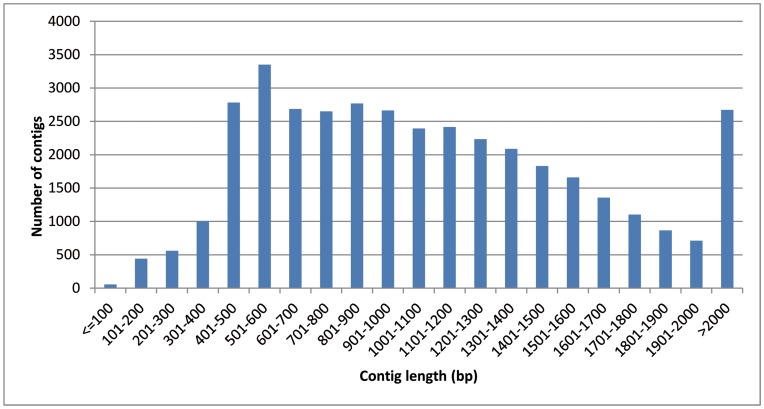
Length distribution (bp) of the 38,297 contigs of the global 454 assembly.